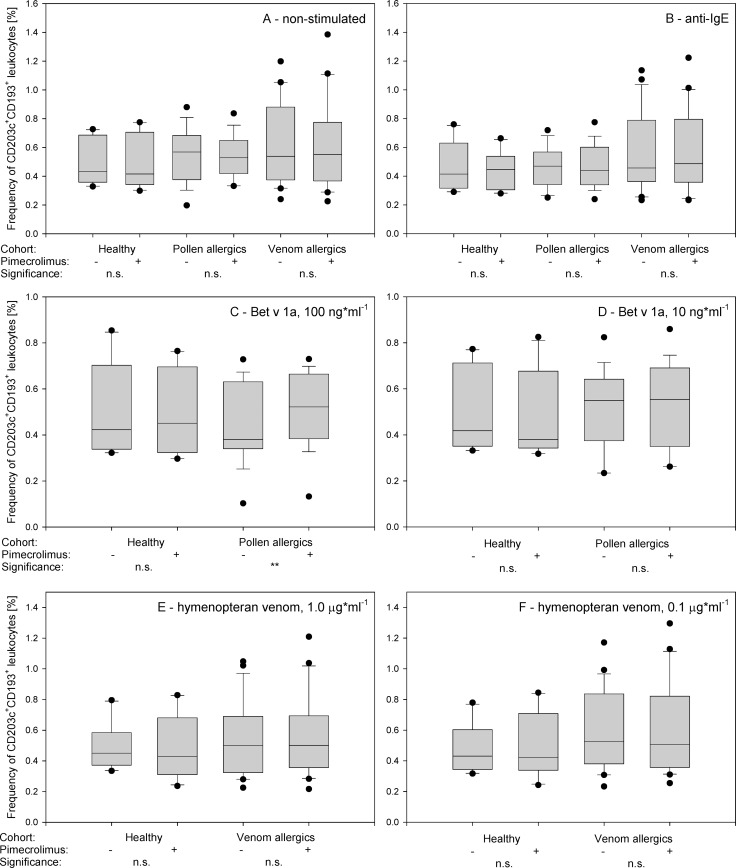
Effects of pimecrolimus treatment on the externalization of CD193 and CD203c.The frequency [%] of SSClowCD203c+CD193+ cells among the total leukocytes is shown. The IL-3-primed basophils were pre-treated or not with 2.5 μMol pimecrolimus and analyzed prior to (A) and after activation with anti-IgE (B), birch pollen allergen Bet v 1a at 100 ng*ml-1 (C) and 10 ng*ml-1 (D), and hymenopteran venom at 1.0 μg*ml-1 (E) and 0.1 μg*ml-1 (F). The Tukey box plots are shown, the mean values are presented as lines, and the 5th and 95th percentiles are displayed as symbols. The significance was examined by the paired t-tests with Bonferroni correction at n = 18 and is indicated as *** (pcorr<0.001 = puncorr<0.000056), ** (pcorr<0.01 = puncorr<0.00056), * (pcorr<0.05 = puncorr<0.0028) and n.s. (pcorr>0.05 = puncorr<0.0028).